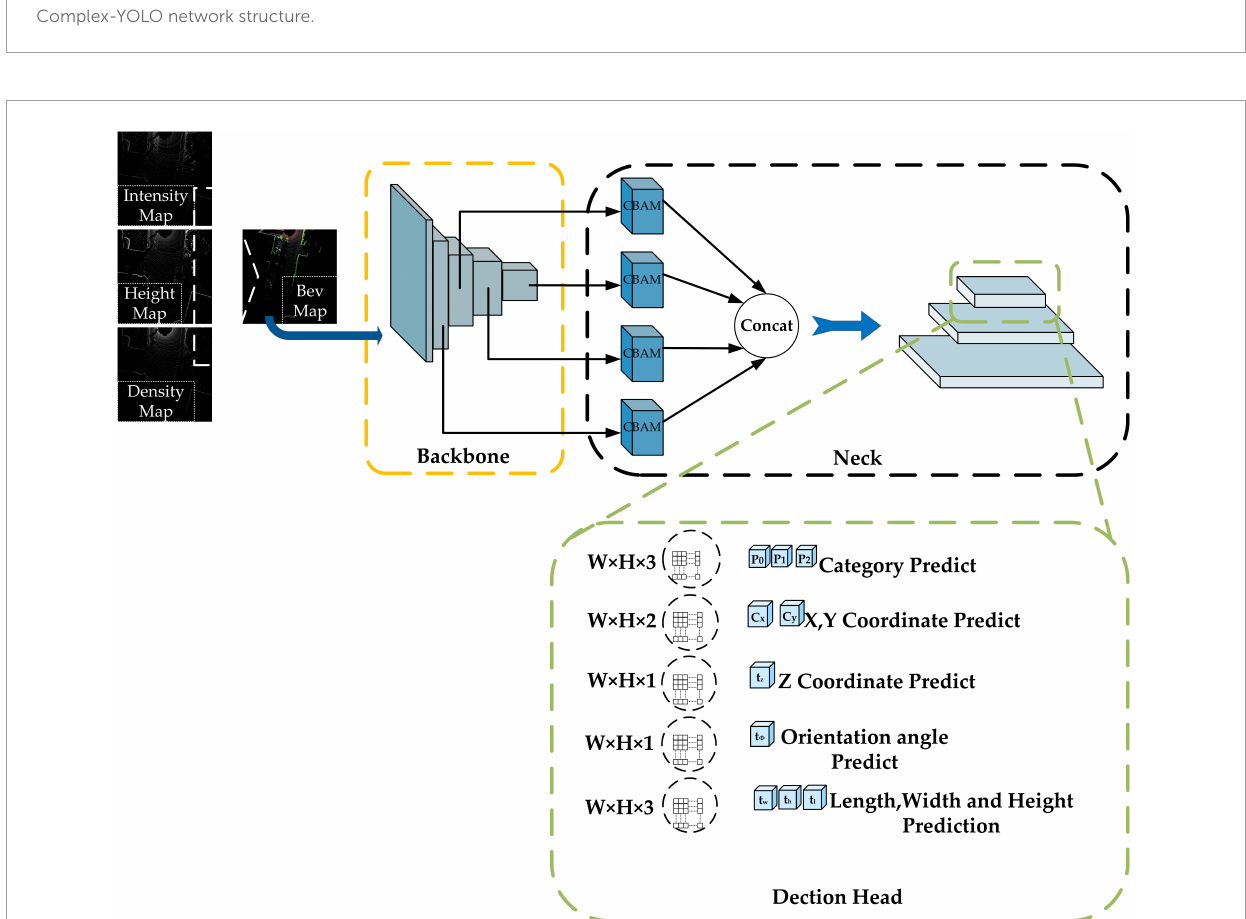
FIGURE3 Efficient Complex-YOLO network structure. The yellow-black-green dashed boxes represent the Backbone, Neck, and Head parts of the network, respectively. W, H, and C represent the length, width, and the number of channels of the feature map, respectively. Efficient Com-plex-YOLO detects small and large objects at 152 × 152, 76 × 76, and 38 × 38 resolutions,